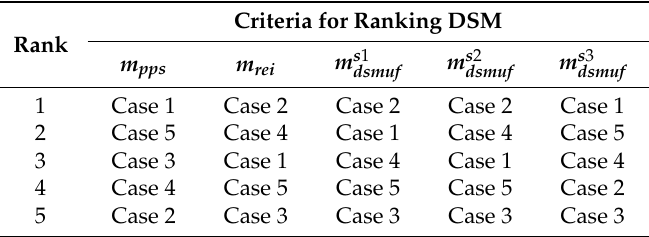
Table 5. OOUI ranks of